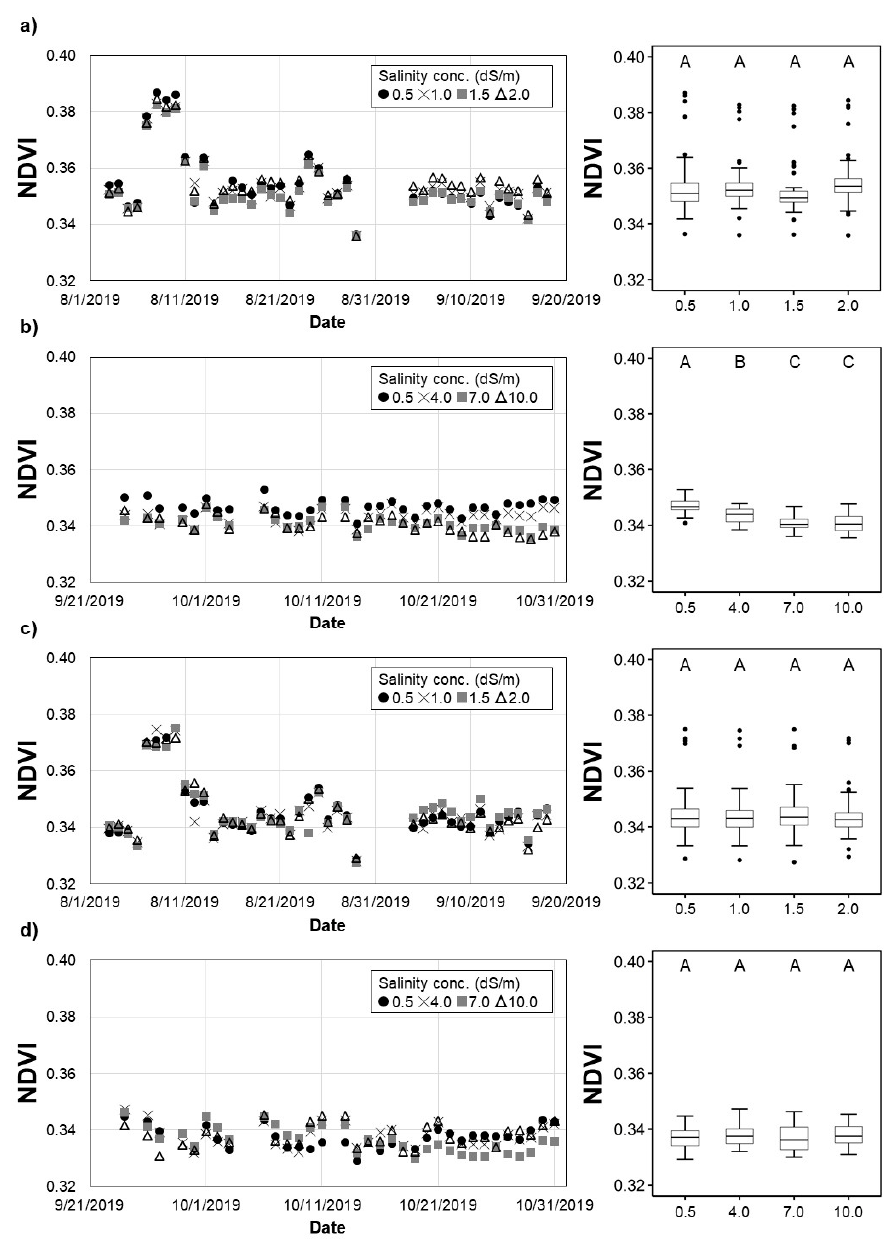
Figure 7. Variation of the NDVI: ( a , b ) H. rosa-sinensis ; ( c , d ) M. splendens ; ( a , c ) first experiment; ( b , d ) second experiment. The same upper-case letters in a figure indicate they are not significantly different at the p < 0.05 level by Tukey’s HSD test.